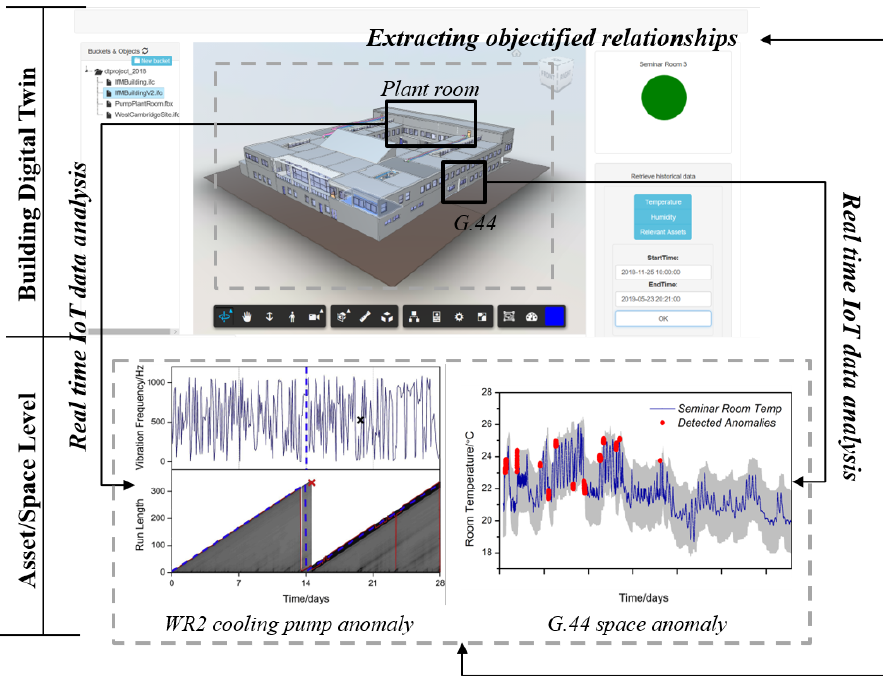
Figure 5. Anomaly detection